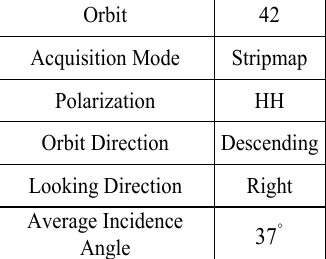
Table 1. System parameters for the pre- and post-event TSX images